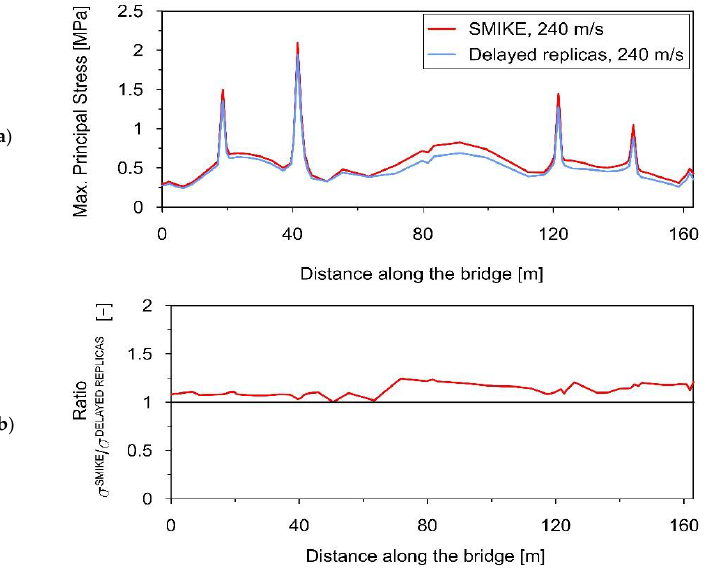
Figure 21. The SMIKE vs. “delayed replicas” models: ( a ) the stress envelopes obtained with the SMIKE model (red line), the delayed replicas model (blue line), ( b ) the stress envelope ratios: SMIKE to delayed replicas model.